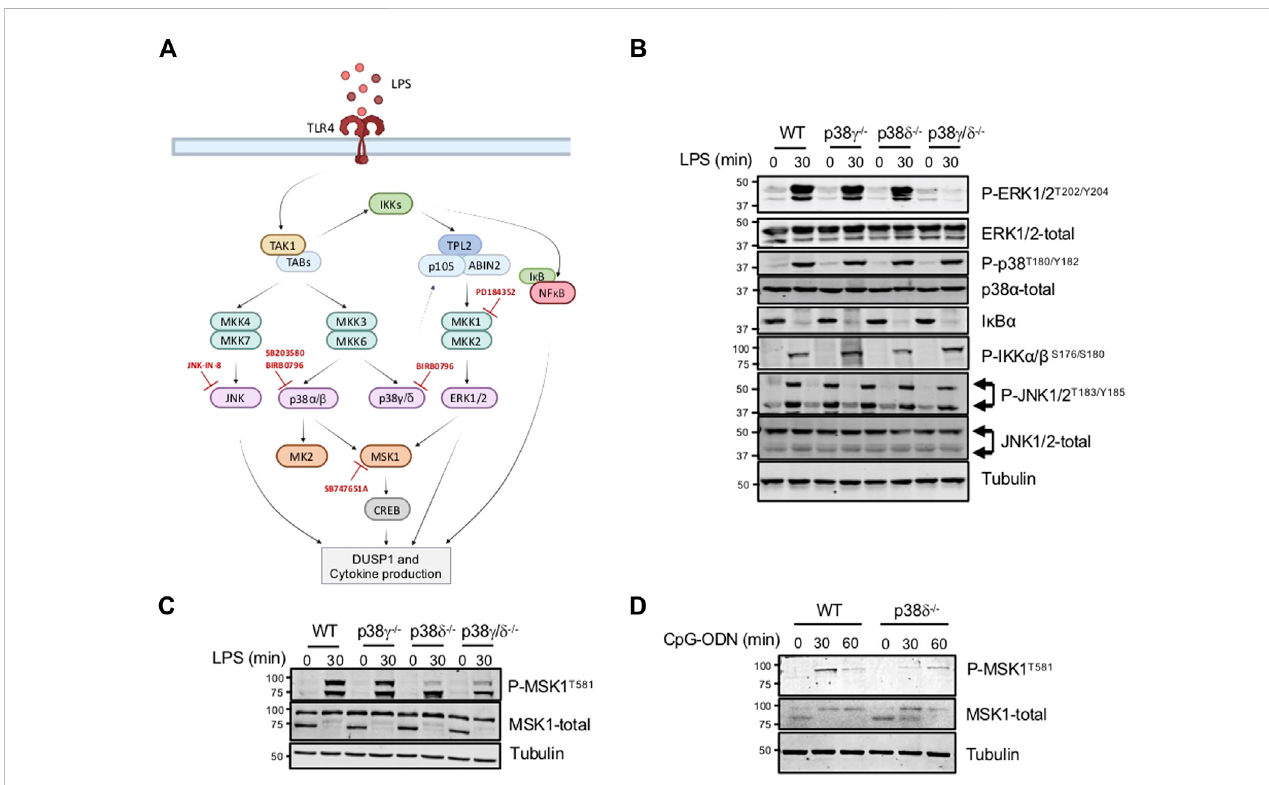
FIGURE 1 MSK1 phosphorylation in impaired in p38 δ − / − macrophages. (A) Schematic representation of the TLR4 signalling pathways involved in MAPK and NF κ B pathwayactivation.TLR4stimulationbyLPStriggerstheactivationofTAK1-IKK-TPL2 via MyD88.p38 γ andp38 δ regulateTPL2steady-statelevels,whichisina complexwithABIN-2andp105(3,8).Thekinasesblockedbytheindicatedinhibitorsareshown. (B,C) BMDMfromWT,p38 γ − / − ,p38 δ − / − orp38 γ / δ − / − micewere stimulated with 100 ng/mL LPS for 30 min. Cell lysates were immunoblotted with the indicated antibodies. Representative immunoblots from three independentexperimentsinduplicateareshown. (D) BMDMfromWTorp38 δ − / − micewerestimulatedwith250 ng/mLCpG-ODNforthetimesindicated.Cell lysates were immunoblotted with the indicated antibodies. Representative immunoblots from three different experiments in duplicate are shown. Molecular weights are indicated at the side of the